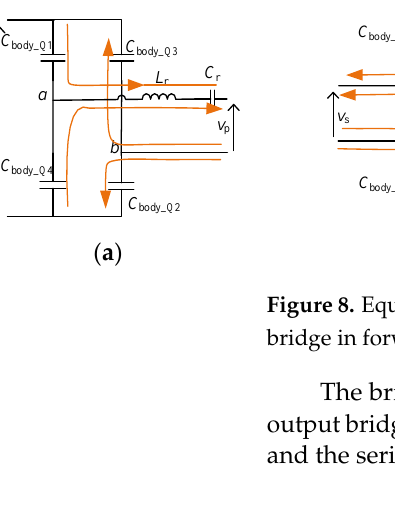
Using regular trigonometry, the expression for I t2 and I t1 in the discharging or reverse modes are the same as the expressions (30) derived in forward mode. The voltage and current waveforms for the reverse mode are shown in Figure 7b. Equivalent circuits rep- resenting the capacitors of the switches ( Q 1 to Q 8 ) for the input and output bridges are